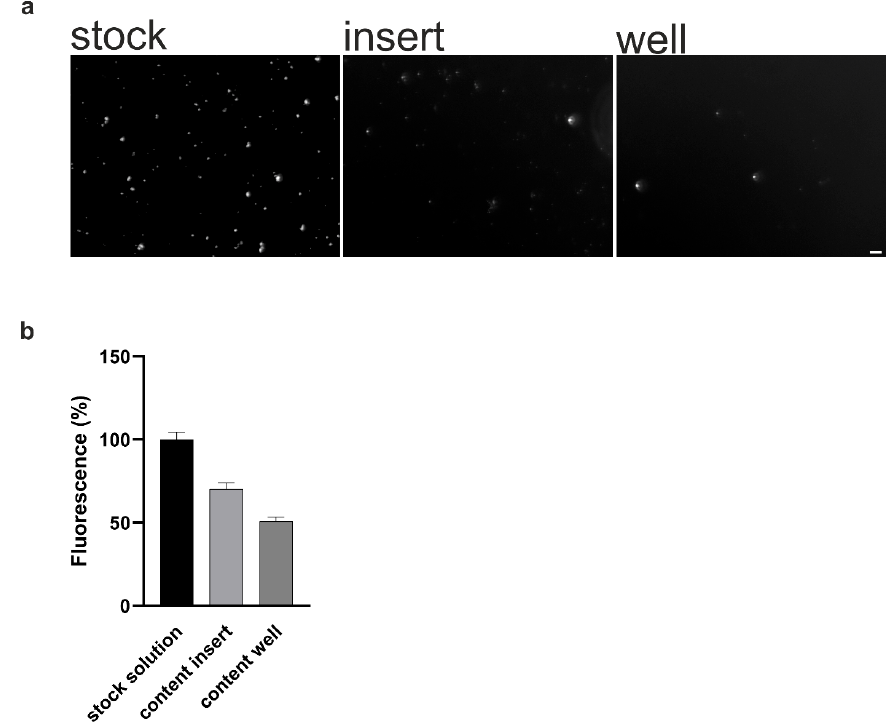
Figure A3. Transfer of nanoparticles (NPs) in a Transwell setting without cells. Representative microscopic images show NPs ( a ) in the stock solution, in the insert (filter) and in the well. Semi ‐ quantitative analysis of the relative fluorescence measured in those 3 solutions is shown in ( b ). Data are given in percentage to the stock solution. Scale bar: 10 μ m.